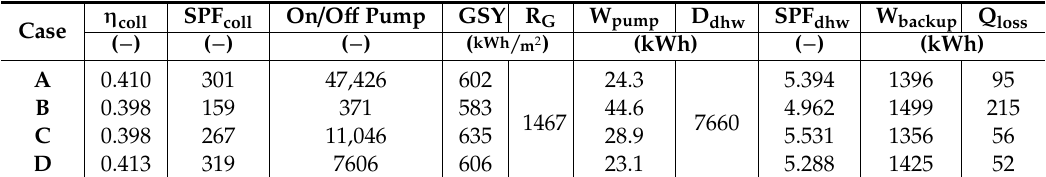
Table 2. Comparison between the four different control strategies—yearly data.